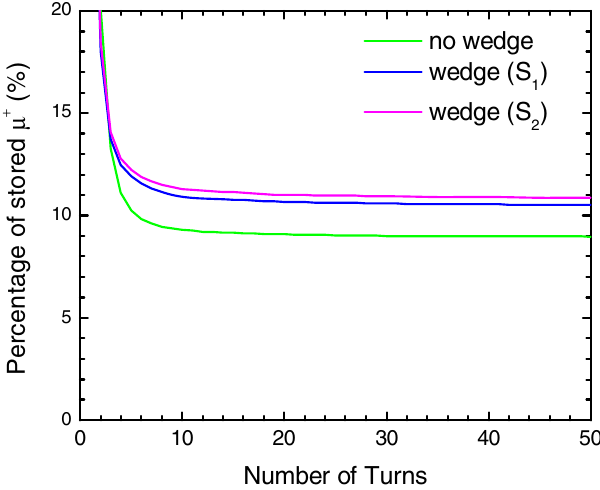
FIG. 14. Simulated transmission through the storage ring of the Muon g-2 Experiment. The green curve shows the case without the absorber. When the wedges are inserted, we see a gain in storable muons which depends on the nearby optics. The blue curve corresponds to optics solution S 1 while the magenta curve corresponds to optics solution S 2